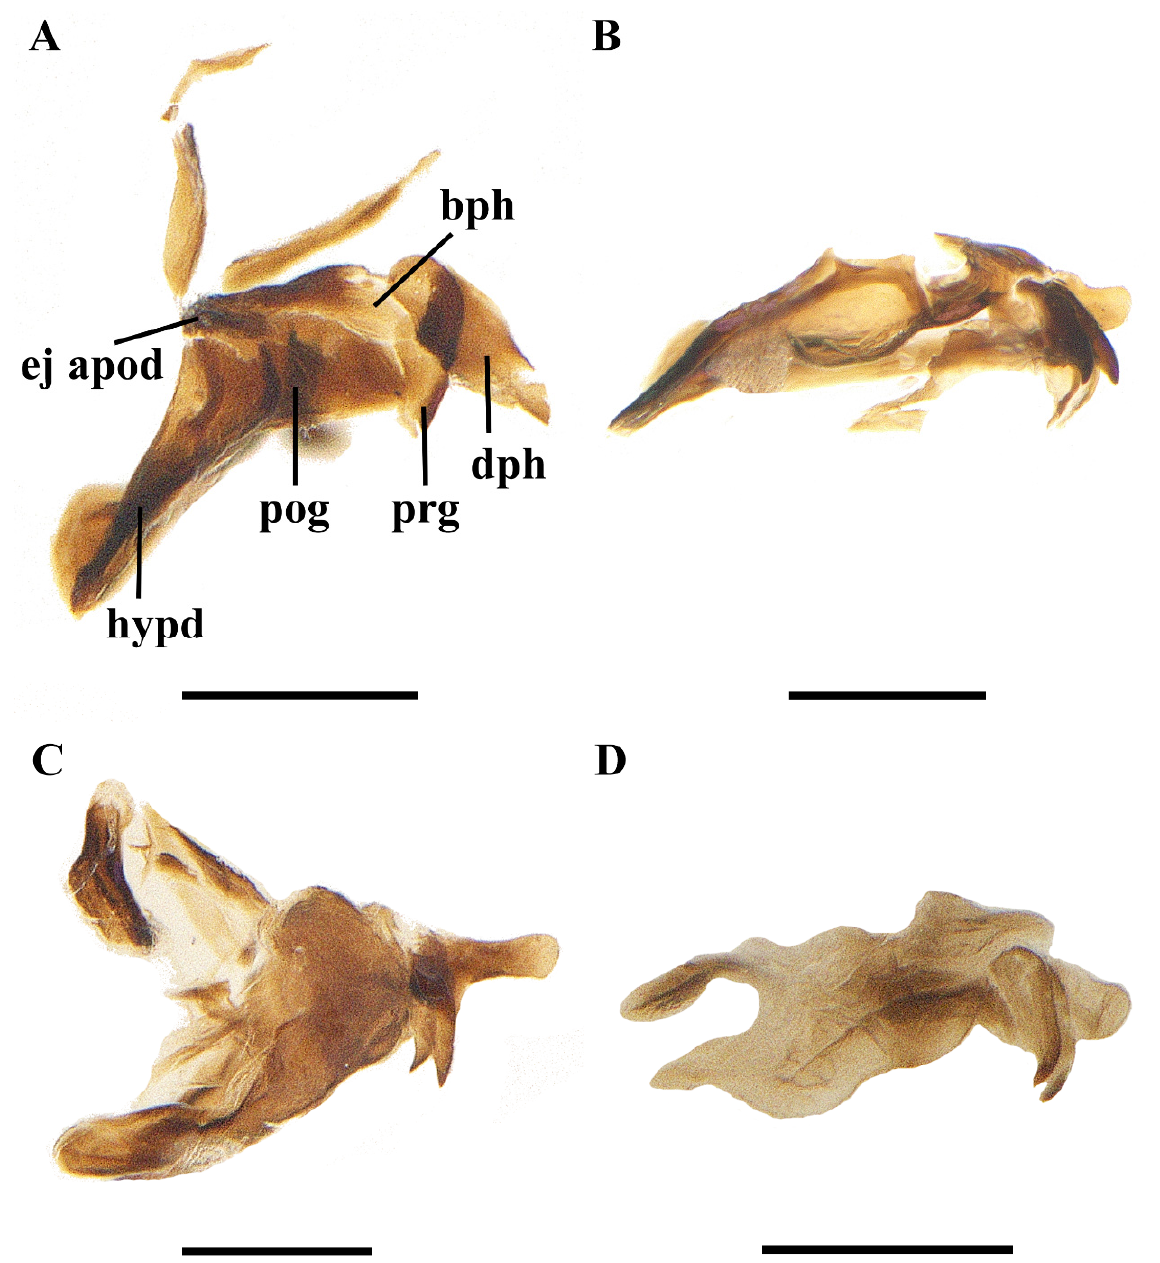
Figure 8. Lateral view of Macquartia spp. phallic complexes. ( A ) M. brunneisquama sp. nov. ( B ) M. chinensis sp. nov. ( C ) M. flavipedicel sp. nov. ( D ) M. flavifemorata sp. nov. Scale bars = 0.2 mm. (Abbreviations: bph = basiphallus; dph = distiphallus; ej apod = ejaculatory apodeme; hypd = hypandrium; prg = pregonite; pog = postgonite.)